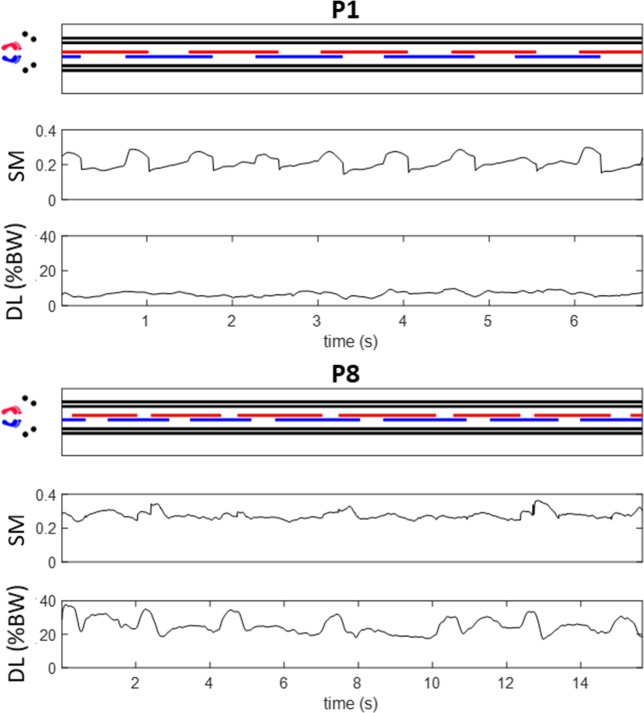
Example data sets for two rollator users (P1: Fit, P8: Frail) walking in a straight line.Top: movement pattern showing times when wheels and feet are in contact with the ground. Middle: stability margin ‘SM’. Bottom: device loading ‘DL’.